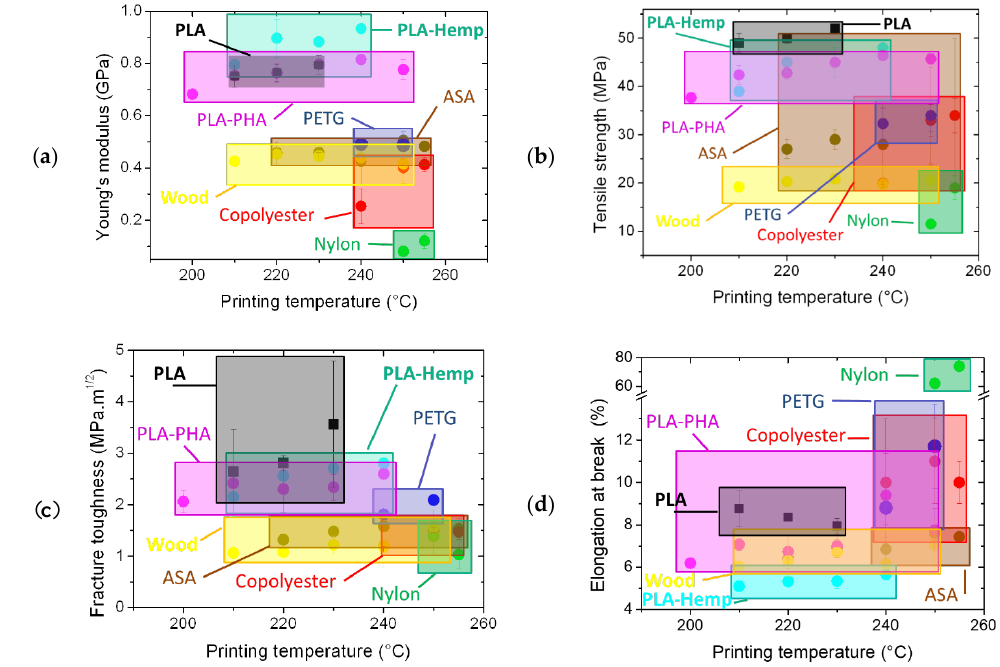
Figure 10. Tensile properties of eight di ff erent feedstock materials for FDM including PLA used in this study: ( a ) Young’s modulus, ( b ) tensile strength, ( c ) fracture toughness, and ( d ) elongation at